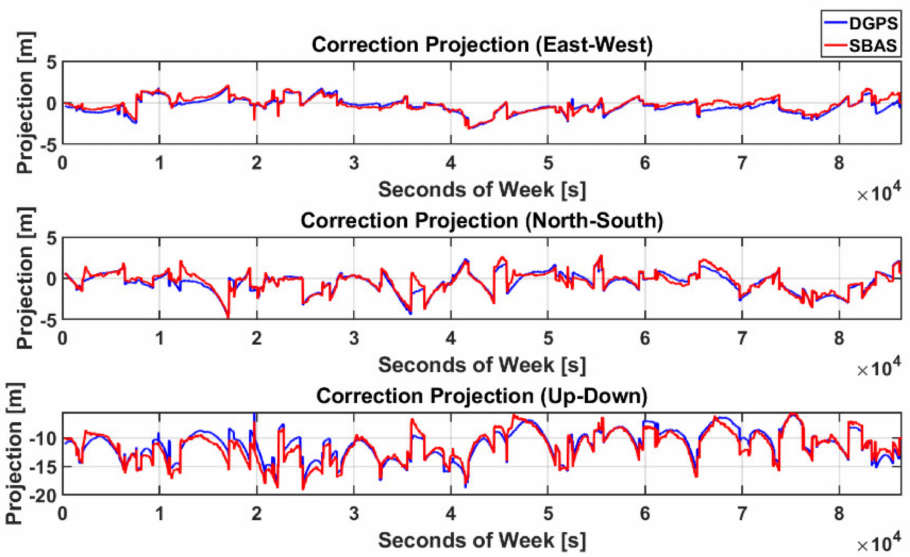
Figure 7. Projection of PRC and RC to the position